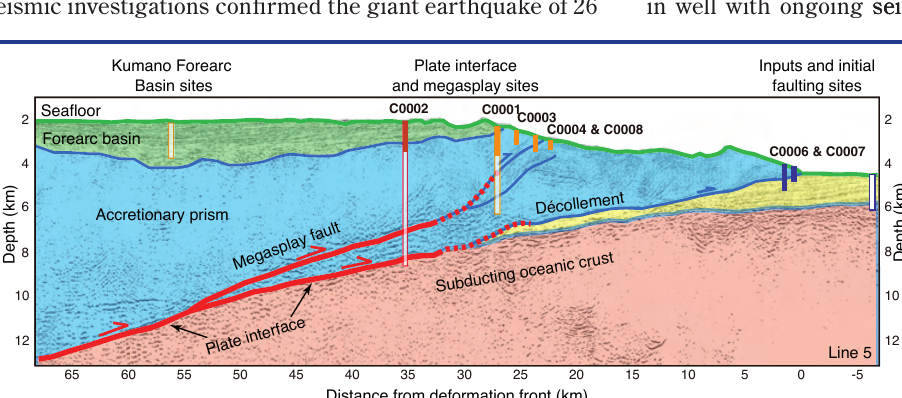
Figure 6. IODP NanTroSEIZE drill sites defining a “distributed observatory” to study the seismogenic zone. Sites drilled during 2007–2008 Stage 1A are shown in solid colors, and are preparatory to much deeper planned drilling that will sample the splay faults and plate boundary seismogenic zone. Modified from Kinoshita et al. (2008); seismic data from Park et al. (2002).